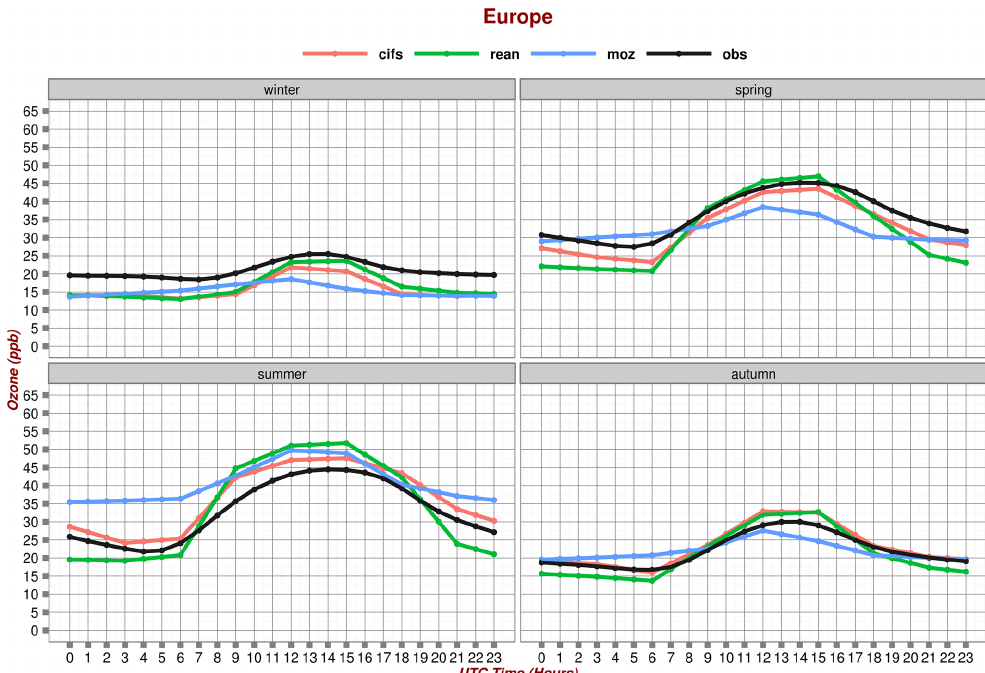
Figure 5. Diurnal cycle of surface ozone volume mixing ratios (ppb) over Europe in winter (top, left), spring (top, right), summer (bottom, left) and autumn (bottom, right) at the rural site of the EMEP and AirBase database and simulated by C-IFS (red), MOZ (blue) and REAN